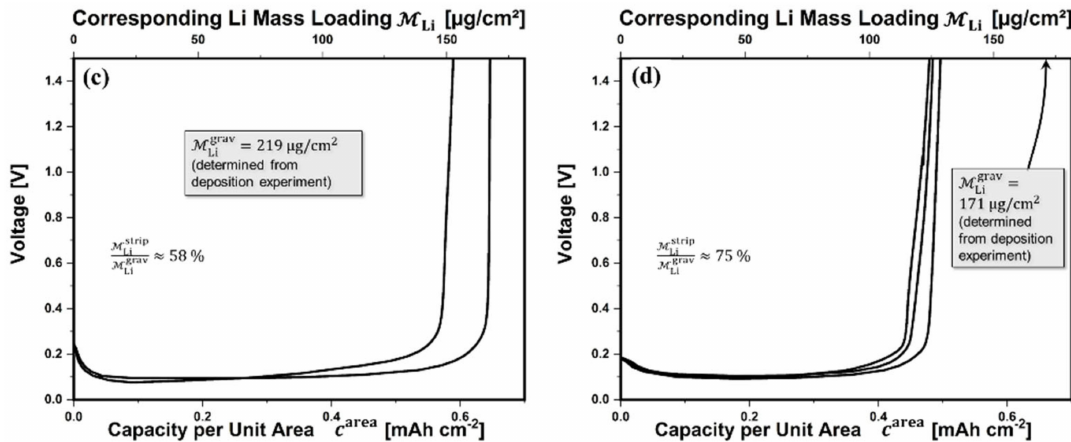
Figure 8. Capacity vs. voltage measurements of several equivalent samples with a porous Li layer ( a , b ) (corresponding to Figure 6a,b) and with an almost compact Li layer ( c , d ) (corresponding to Figure 7a,b). Data from dashed lines and solid lines correspond to samples prepared using Cu substrates that were 1 mm and 2 mm in thickness, respectively. The M Li axis was calculated from the lithium theoretical specific capacity. This leads to the conclusion that up to 85% of the Li is electrochemically